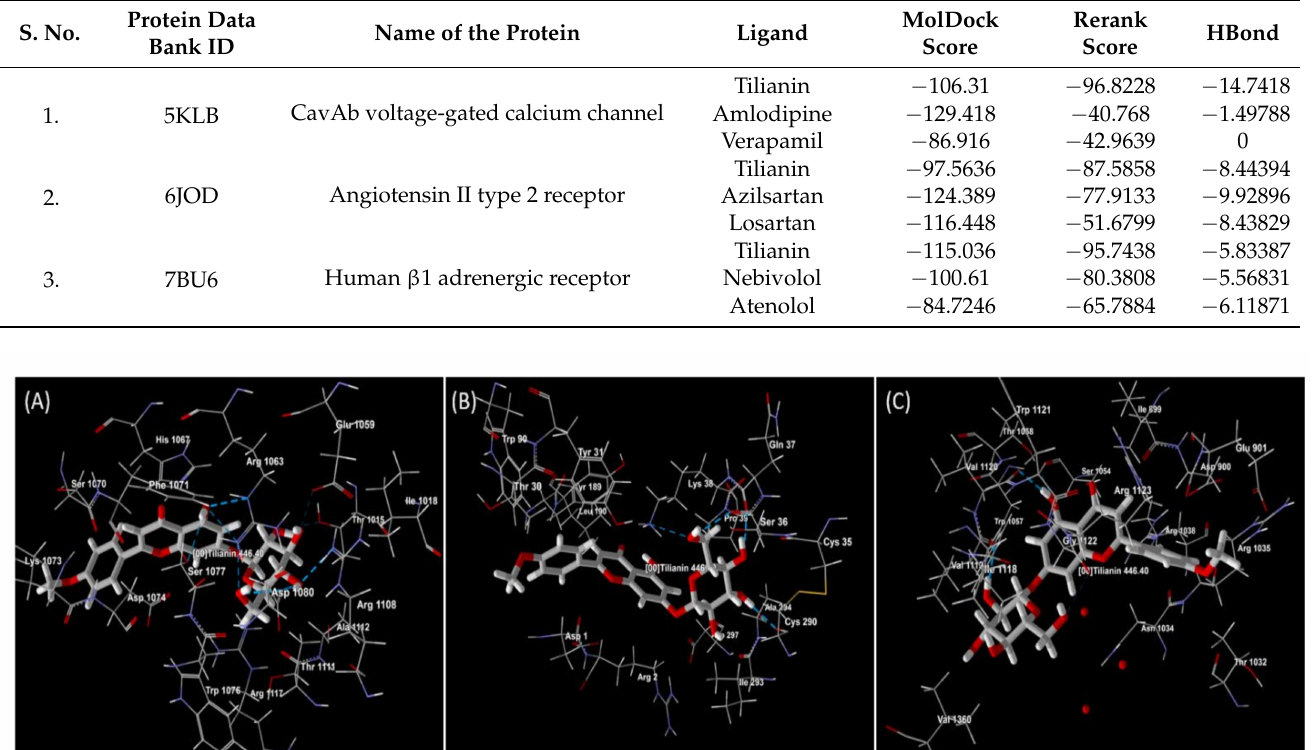
Table 2. Docked study results of tilianin and standard drugs with the CVD target proteins.